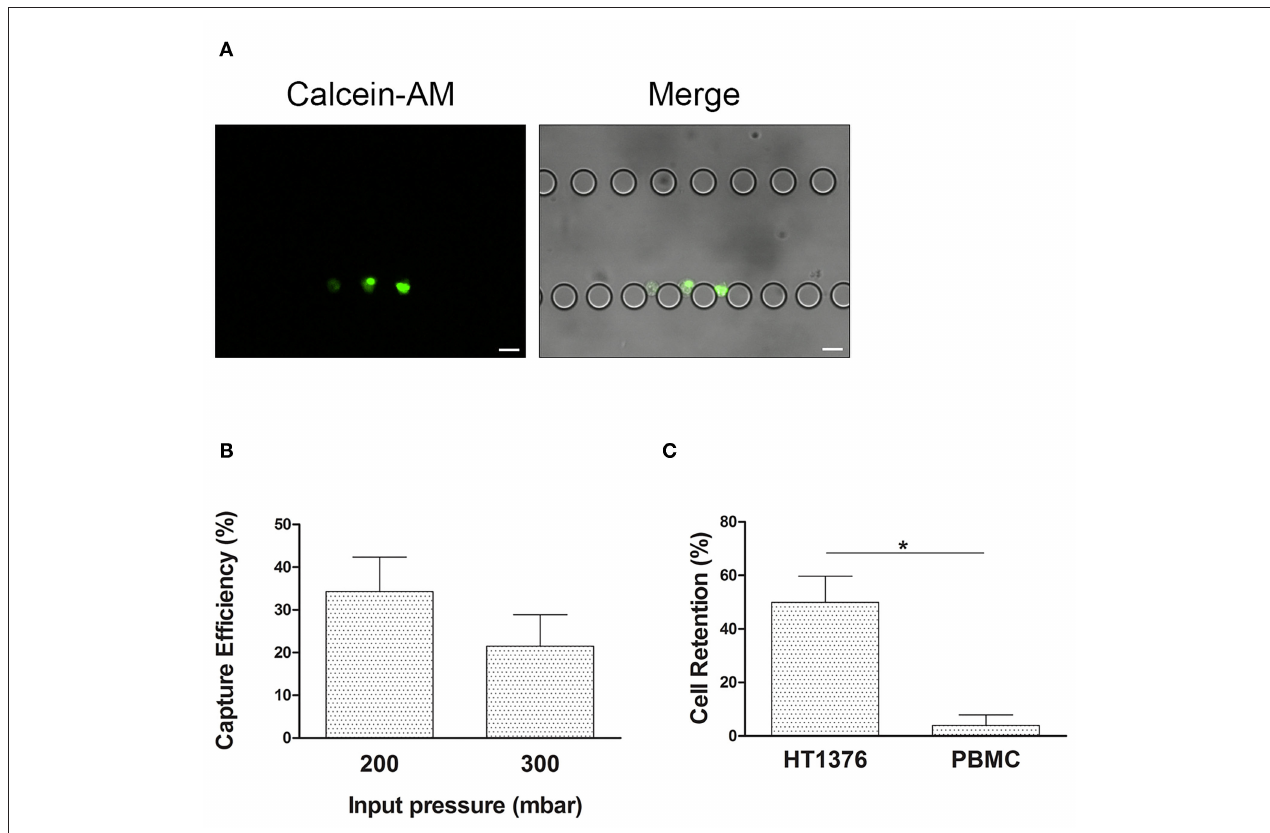
FIGURE 3 | UriChip performance with HT1376 bladder cancer cells. (A) HT1376 cells (pre-stained with calcein-AM) captured in the UriChip and visualized by fluorescence microscopy. Scale bar, 20 µ m. (B) Capture efficiency (CE) of HT1376 cancer cells spiked in PBS and run at 200 and 300 mbar. (C) CE of HT1376 cells spiked in PBS solution containing PBMCs at 200 mbar input pressure (50%). Results are described as Mean ± S.D. of three independent experiments. * indicates statistical significance ( p <